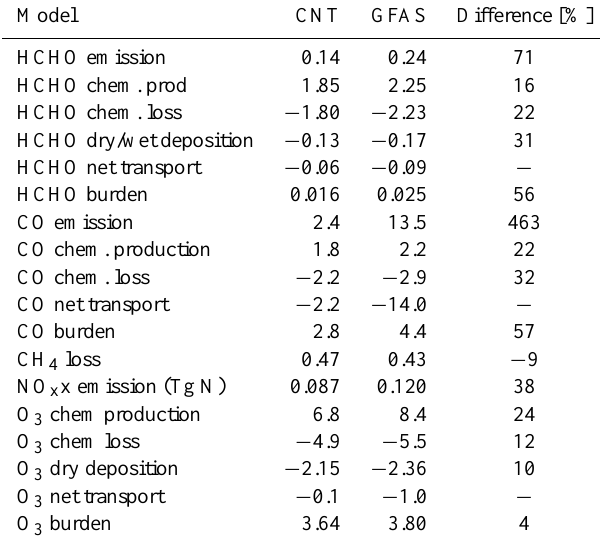
Table 14. CO, HCHO and O 3 tropospheric chemical budgets in Tg, for runs CNT and GFAS, and the relative change expressed as (GFAS-CNT)/(CNT), calculated for the period 15 July–5 August over western Russia. The imbalance in the HCHO, CO and O 3 bud- gets corresponds to the net mass